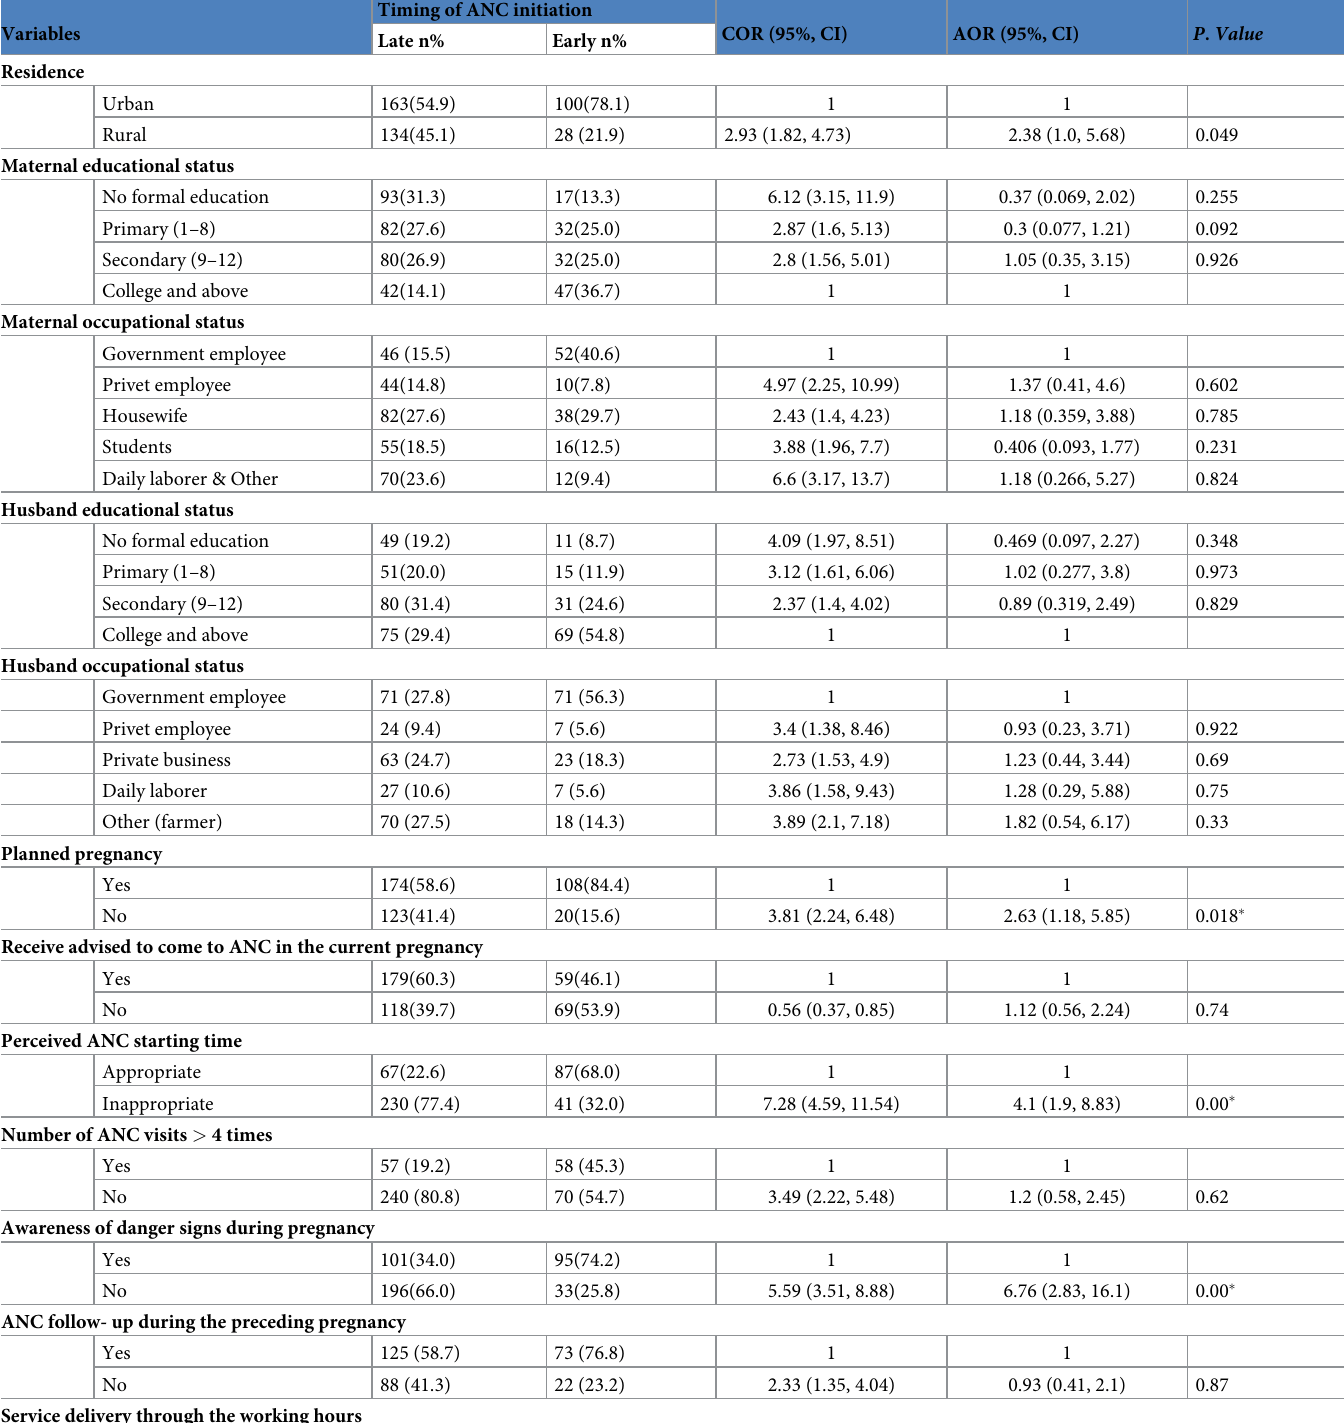
Table 6. Factors associated with late initiation of ANC in Mizan Aman town, southwest, Ethiopia,